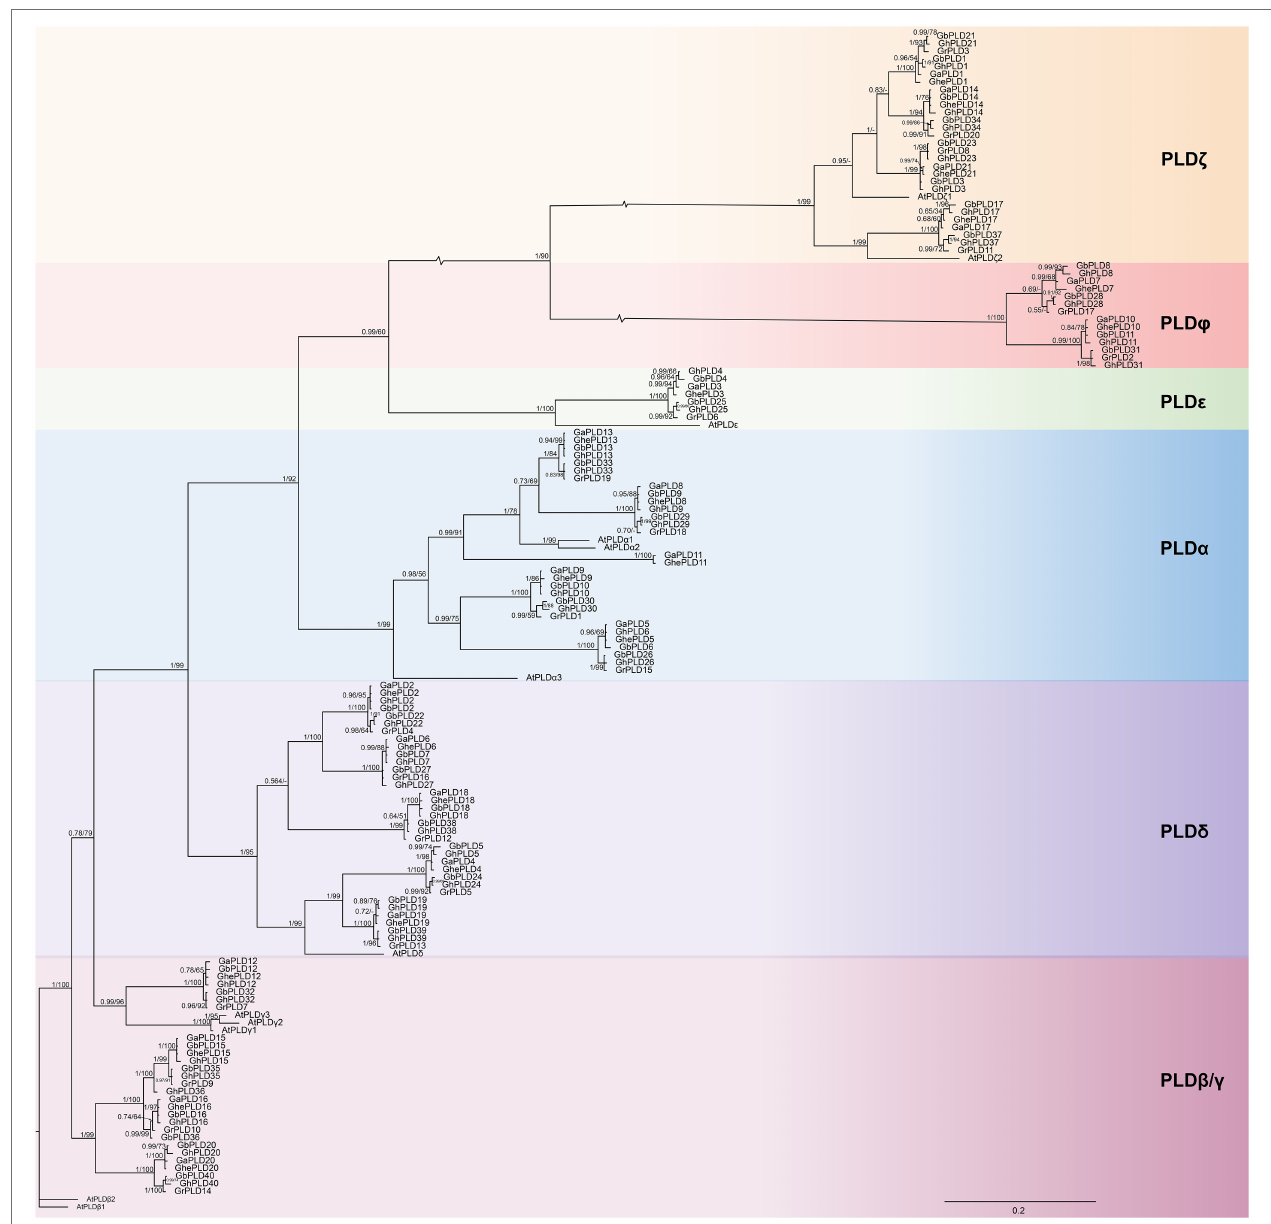
FIGURE 1 | Phylogenetic tree of the phospholipase D (PLD) gene family. Molecular phylogenetic analysis of 154 PLD proteins from Gossypium hirsutum , G. barbadense , G. herbaceum , G. arboreum , G. raimondii , and Arabidopsis thaliana . Groups α , β / γ , δ , ζ , ε , and φ show the phylogenetic clusters of genes. Different groups are represented using different background colors. Numbers at nodes correspond to posterior probabilities from Bayesian analysis (left) and the bootstrap value from ML analysis (right). Scale bar indicates the rates of